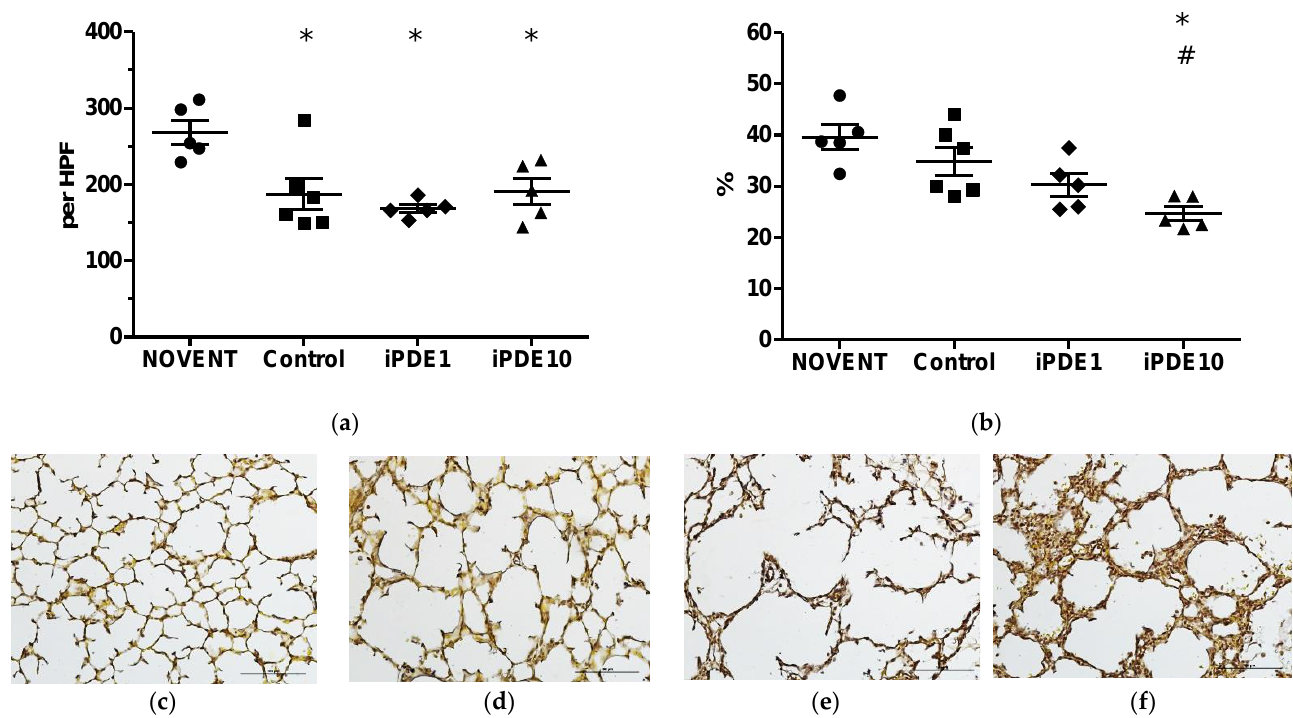
Figure 5. ( a ) Total number of profiles of elastin foci per HPF and ( b ) relative amount of profiles of elastin foci located at the budding secondary septae (* p < 0.05 vs. NOVENT, # p < 0.05 vs. control). Example images at 400× magnification for ( c ) NOVENT, ( d ) Control, ( e ) iPDE1 and ( f ) iPDE10.